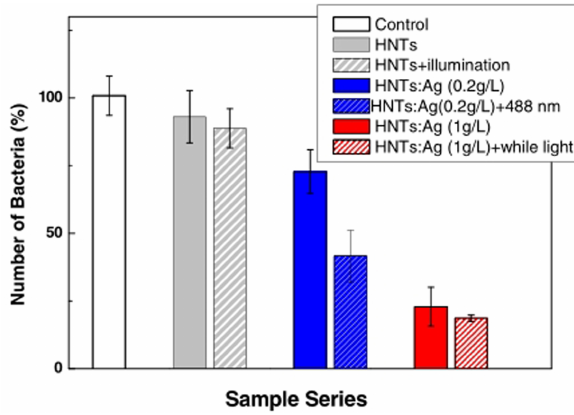
Figure 14: Relative number of E. coli bacteria after incubation with- out (control) and with bare HNTs (1 g/L) in darkness (grey bars) and under illumination (pattern grey bars) as well as with HNTs (0.2 g/L) covered by Ag NPs (blue bars) in darkness and under illumination at 488 nm (blue pattern bars), and HNTs (1 g/L) covered by Ag NPs (red bars) in darkness and under illumination with white light (red pattern bars) (conducted by Jana et al. ) [132]